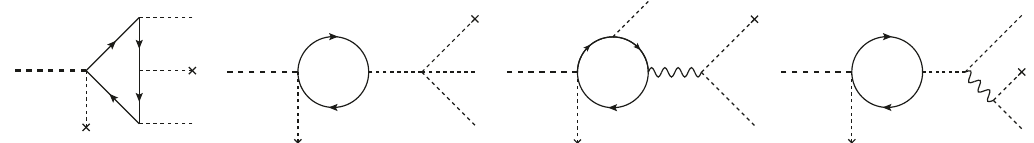
Figure 6 . Representative one-loop diagrams contributing to the matching condition for the Wilson coe(cid:14)cients e C (cid:30)(cid:30)(cid:30)(cid:30) in (6.20). Dashed lines with a cross denote zero-momentum insertions of the scalar (cid:12)eld ’ 0 . In the (cid:12)rst and third graph one must sum over all possible attachments of the 0 scalar lines on the fermion